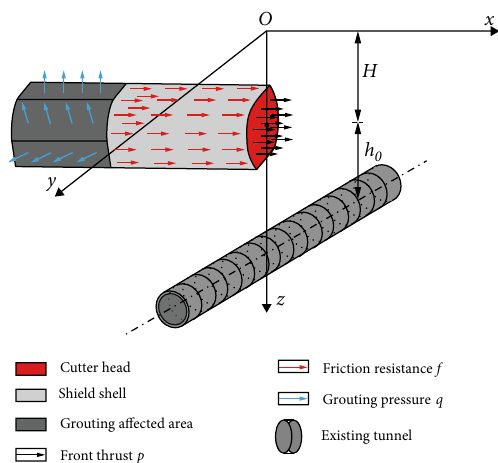
Figure 1: Diagram of construction calculation for quasirectangular shield